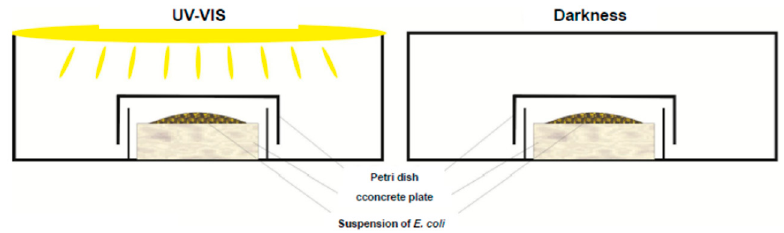
Figure 5. Schematic experimental setup.